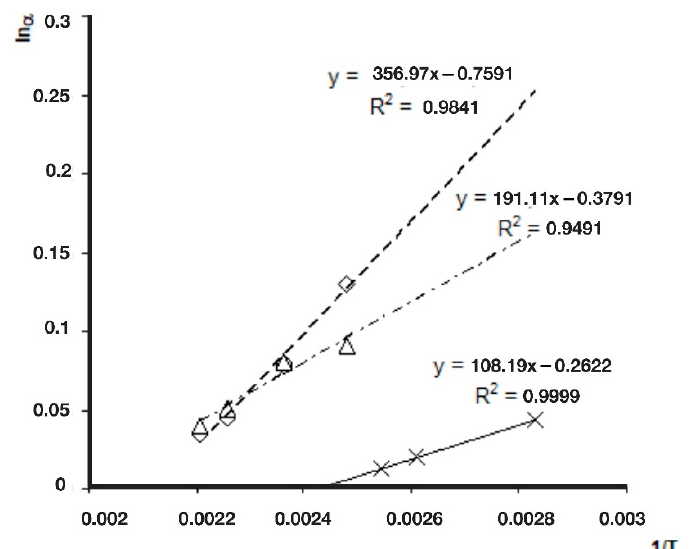
Figure 4. The natural logarithm of chiral selectivity values (ln α ) of permethrinic acids in the function of inverse absolute temperatures (1/T). Symbols: ♦ , cis -permethrinic acid; ∆ , trans -permethrinic acid; x, cis -permethrinic acid methyl ester. No chiral separations were recognized for trans -permethrinic acid methyl ester, even at 80 ◦ C. Conditions: instrument, Shimadzu GC/MS-QP5000 GC/MS; column, 25 m × 0.22 mm; stationary phase, Cydex-B (0.25 µ m); carrier, He (50